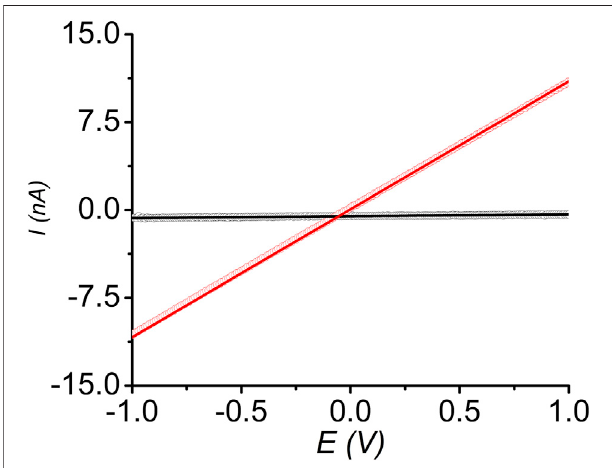
FIGURE 7 | Linear I-V relationships ofpristine (black) and I 2 -treated (red) sine -MOF measured by two-probe method.